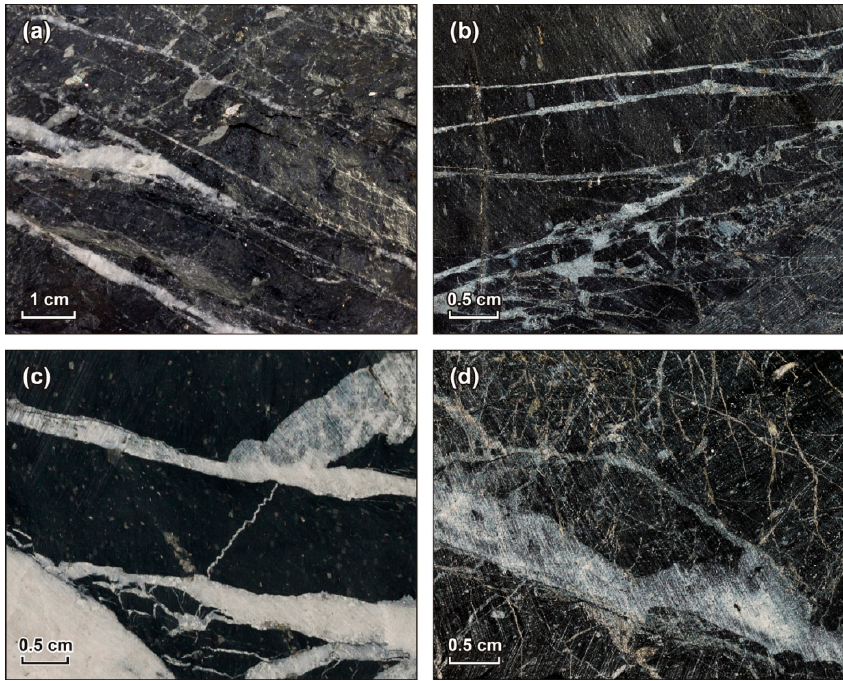
Figure 2. Gold-bearing streaky-vein and veinlet-disseminated ores. ( a ) Sample Nat-10 of the Natalkinskoe deposit, central area, quarry (level 787.5 m). Intensively sulphidized and carbonized aleuropelitic shales with the inclusions of grey tufogenic material dissected with a dense network of quartz and quartz–carbonate veinlets of different widths, from hair like to 5 mm. Sulphide minerals are represented by disseminated pyrite and arsenopyrite. Pyrite crystals are cubes, pentagon dodecahedrons and cuboctahedrons, mainly up to 2 mm along an edge. Arsenopyrite crystals are represented by rhombic prisms and bipyramids, usually up to 0.5 mm along an edge. The combinations of simple forms are typical for both minerals. ( b ) Sample UV-3/13 of the Natalkinskoe deposit, south-eastern area, well DH70/5n, depth 160.1–163.1 m, level 590 m. Heavily sulphidized and carbonized siltstones and aleuropelitic shales with interlayered sandstones dissected with a network of quartz and quartz–carbonate veinlets of different width. The characteristics of ore minerals are the same as for Nat-10 except that pyrite predominates over arsenopyrite and the crystals of the later are coarser (up to 3 mm). ( c ) Sample DG-10/14 of the Degdekan deposit, Vernyi area, well DH221n, depth 231.9–233.9 m (level 470 m). Quartz veins and veinlets occur in heavily carbonized and sulphidized siltstones and characterized by a few centimetres and a few millimetres (up to 8 mm) width, accordingly. The sulphides are represented by impregnations, patches and fine stringers of pyrite. The coarse cubic crystals prevail (more than 2 mm in size). Arsenopyrite, mostly confined to veins and veinlets, is less common and represented by small rhombic-prismatic crystals (up to 0.5 mm). ( d ) Sample ZR-10/13 of the Zolotaya Rechka deposit, well DH444n, depth 307.4–310.3 m (level 310 m). Heavily fractured aleuropelitic shales dissected with a dense network of quartz veinlets of different widths, from hair like to 8–10 mm. Sulphides are represented by impregnations and patches of pyrite and arsenopyrite. Pyrite crystals are cubes and cuboctahedrons, mainly up to 2 mm along an edge. The combined forms are often observed. Arsenopyrite crystals are usually smaller (up to 0.5 mm) and have the habits of rhombic prisms and bipyramids. The study here of PGEs, in addition to Au and Ag, the determination of their contents and forms of occurrence in ores and minerals, holds a special place in the research and is important not only theoretically but also practically. The presence in the ores of these NMs and the possibility of their extraction can supplement significantly the range of already known platinum-bearing ore formations and essentially increase the value of the extracted Au ore raw materials in the deposits where